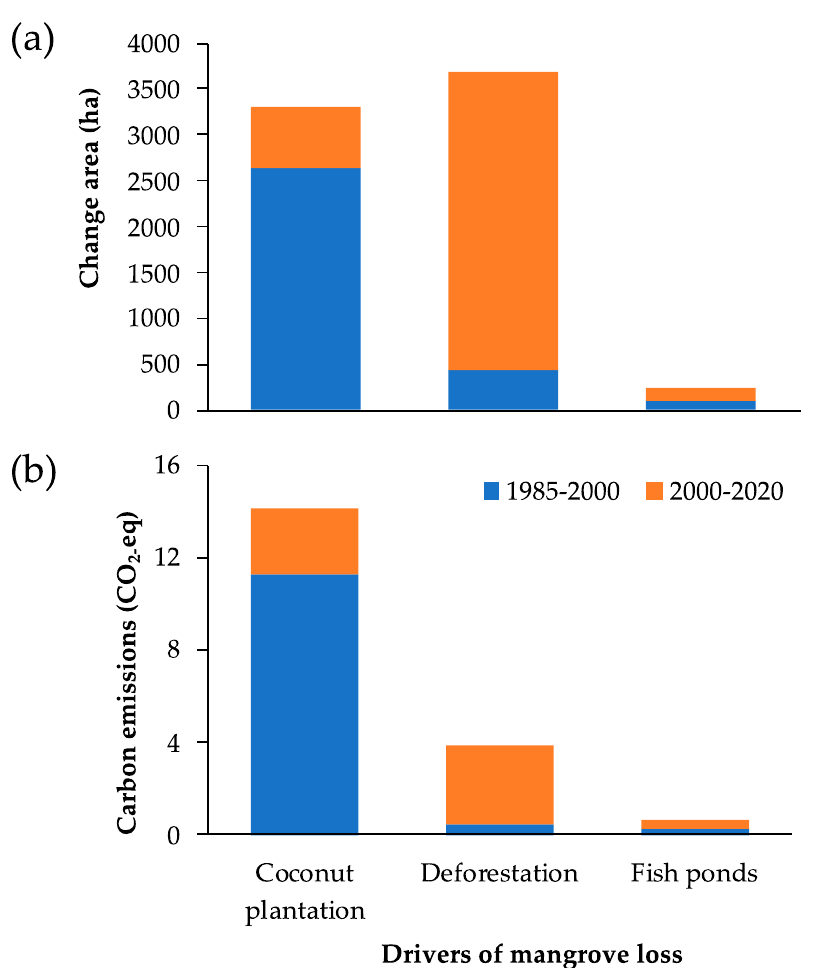
Figure 6. ( a ) Area of converted mangroves (combined primary and secondary forests) to other land uses, and ( b ) their associated carbon emissions, between 1985–2000 and 2000–2020. Table 5. Quantitative land cover changes during the periods of 1985–2000 and 2000–2020. Land Cover Changes (ha) Land Cover Types